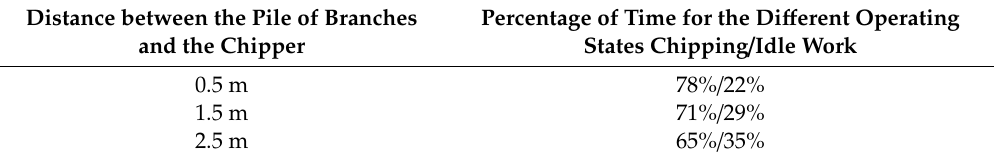
Table 1. Percentage of operating conditions times depending on the distance between the branch stack and the